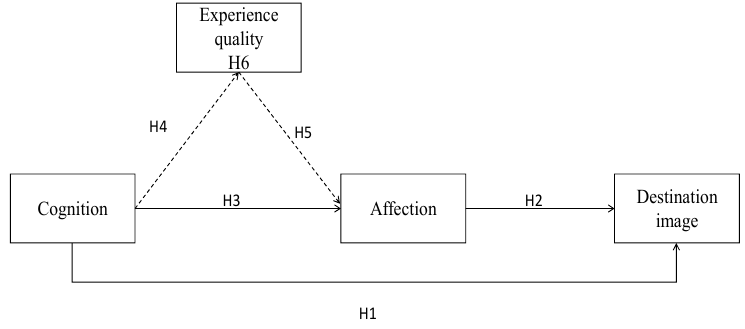
Figure 1. Conceptual framework and hypotheses of the